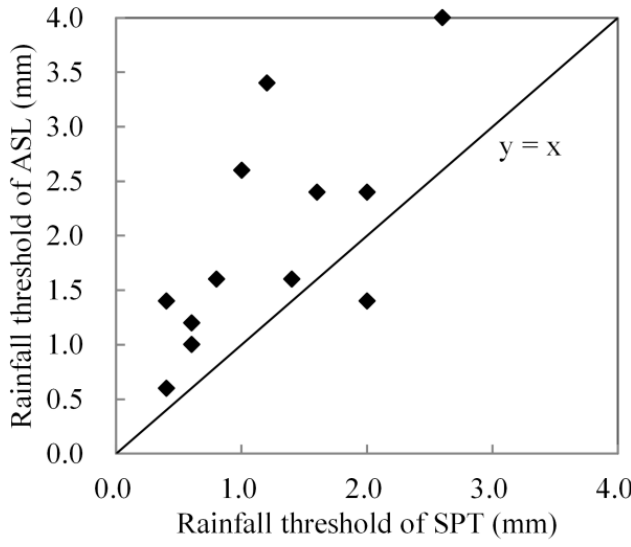
Figure 5. Difference of rainfall thresholds of throughfall between SPT and ASL. Figure 5. Di ff erence of rainfall thresholds of throughfall between SPT and ASL.